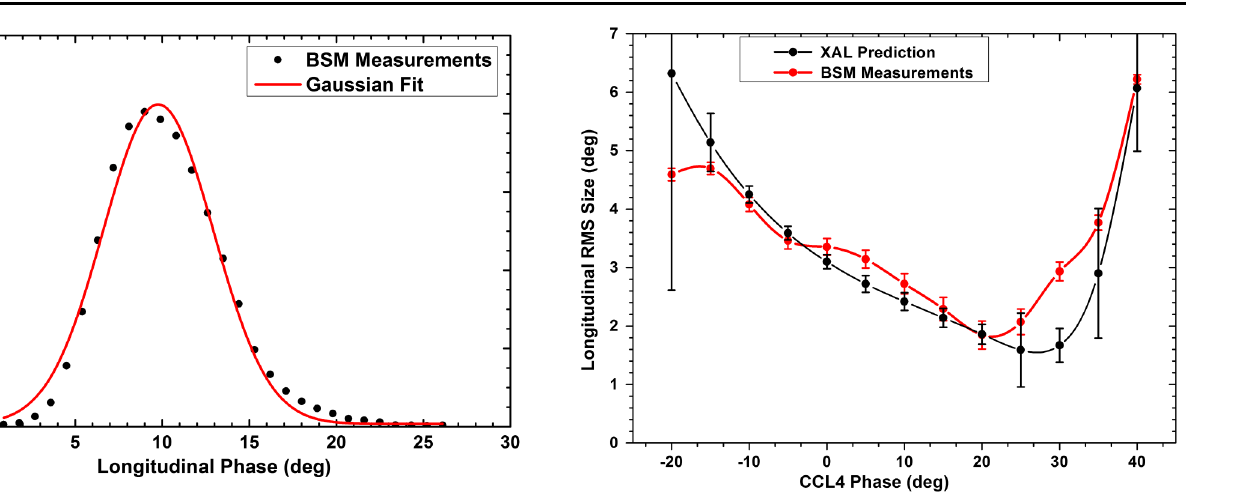
FIG. 5. The longitudinal bunch size at the CCL BSM410 as a function of the CCL4 cavity phase. The zero phase is the design phase of the cavity. Red: the direct BSM measurements. Black: SCL BPMs (new method) with XAL prediction at the CCL4 BSM410 location.